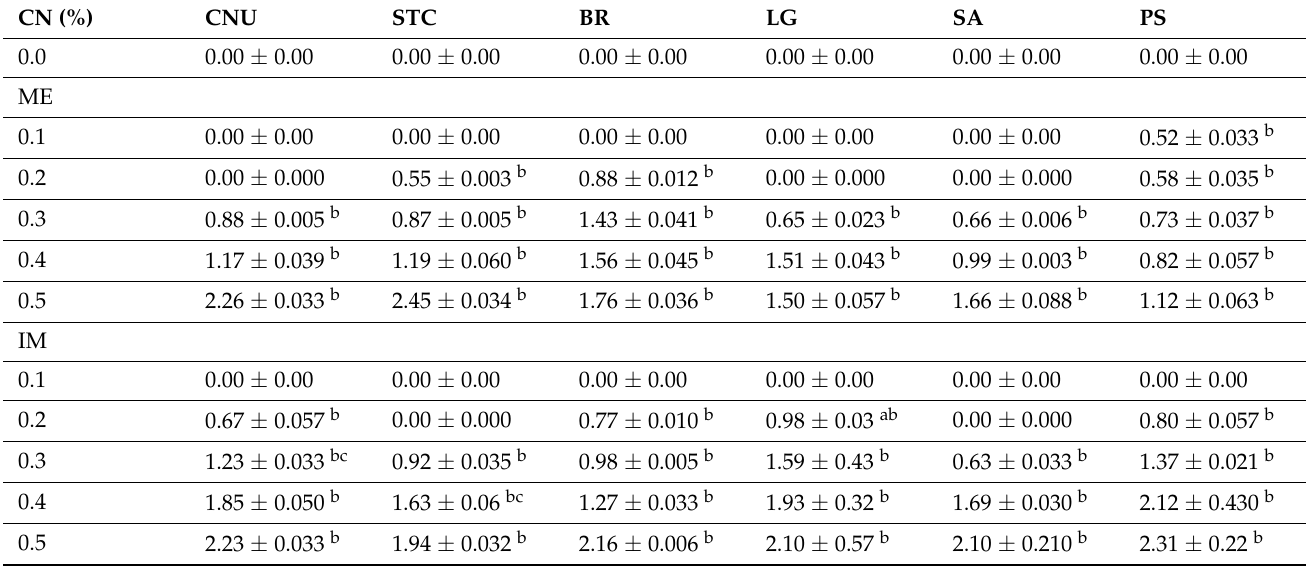
Table 4. Percentage of meiotic abnormality in metaphases I and II and anaphases I and II of plates of P. sativum in PMCS exposed to different concentrations of ME and IM for 1 h.